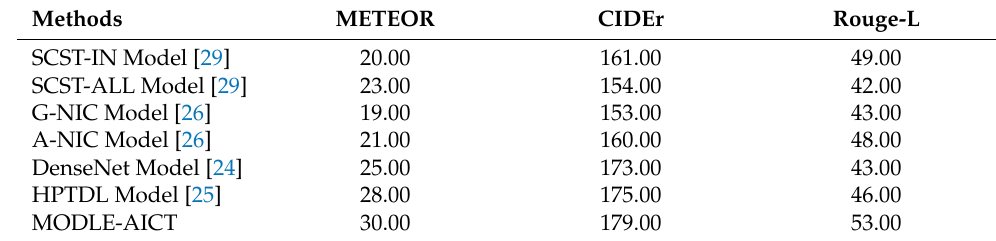
Table 3. Classification analysis of MODLE-AICT algorithm with approaches on Flickr8K